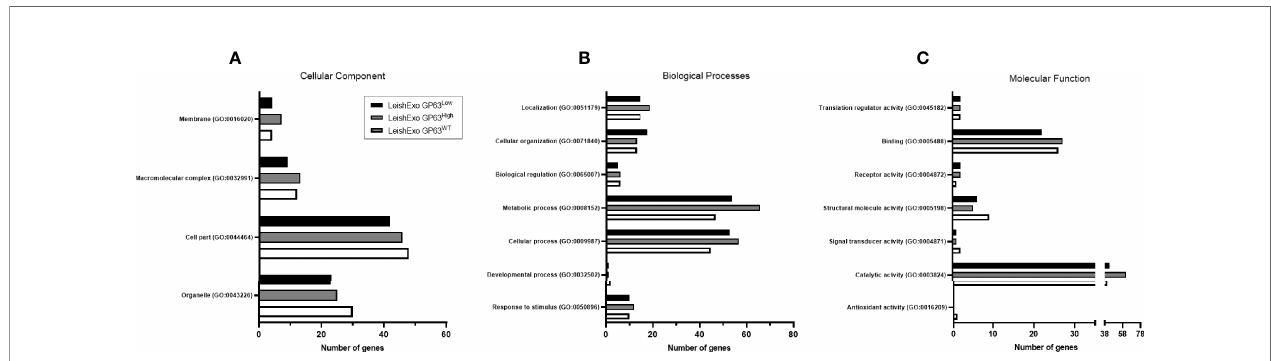
FIGURE 3 | Gene Ontology analysis of various Leishmania amazonensis-derived EV proteins detected by Mass Spectrometry. GO annotations of detected proteins on Leishmania amazonensis GP63 WT , GP63 High, and GP63 Low -derived EVs. Cellular components (A) , biological processes (B) , and molecular functions (C) are displayed. Proteins detected on LeishEXO GP63 High and GP63 Low had more genes classi fi ed as related to metabolic processes and cellular processes in comparison to LeishEXO GP63 WT . Additionally, an increased number of genes classi fi ed to the catalytic activity is observed on the group LeishEXO GP63 High , which correlates with the number of unique proteins in this group related to this molecular function. Analysis performed with Panther classi fi cation system